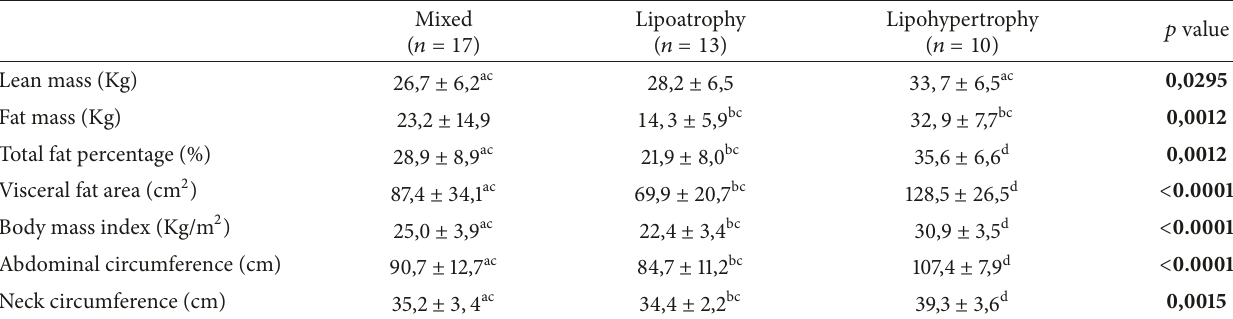
Table 7: People living with HIV/AIDS body composition with clinical HIV-associated lipodystrophy syndrome diagnosis separated by HALS